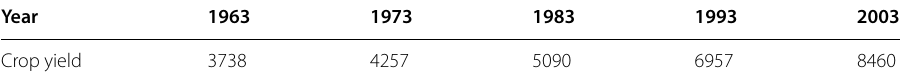
Table 3 Crop yield (value output Rs. per hectare of gross cropped area): India. Source : Government of India, Area and Production of Principal Crops in India (various issues), Min- istry of Agriculture